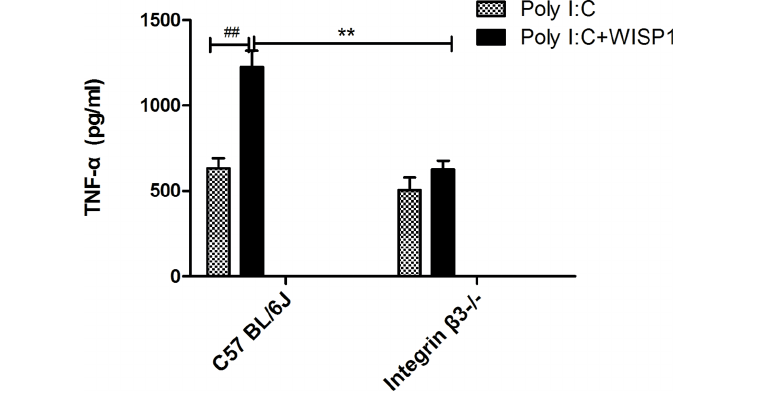
Figure 8. Effects of integrin β 3 knockout on WISP1 plus poly(I:C)-induced TNF- α production in macrophages. Peritoneal macrophages isolated from C57BL/6J and integrin β 3 knock- out mice were treated with WISP1 (10 μ g/mL) and poly(I:C) (5 μ g/mL) for 16 h in serum free medium. TNF- α levels in the supernatant were measured by ELISA. Data are pre- sented as mean ± SEM (n = 5) and compared by two-way ANOVA. *** P < 0.001 C57BL/6J versus integrin β 3 knockout after WISP1 plus poly(I:C)